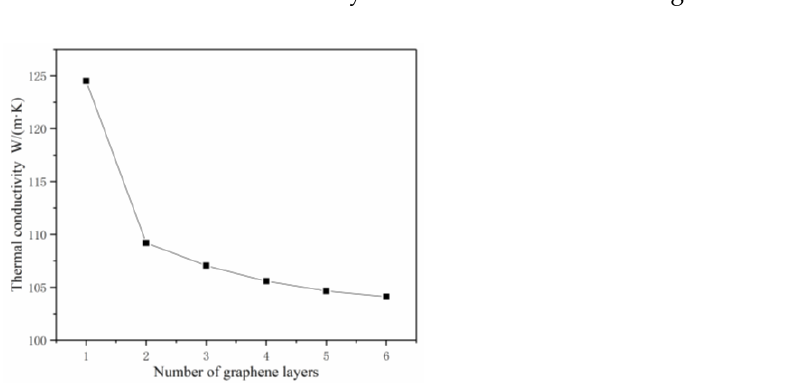
Figure 11. The K c of models of graphene with different degrees of agglomeration.